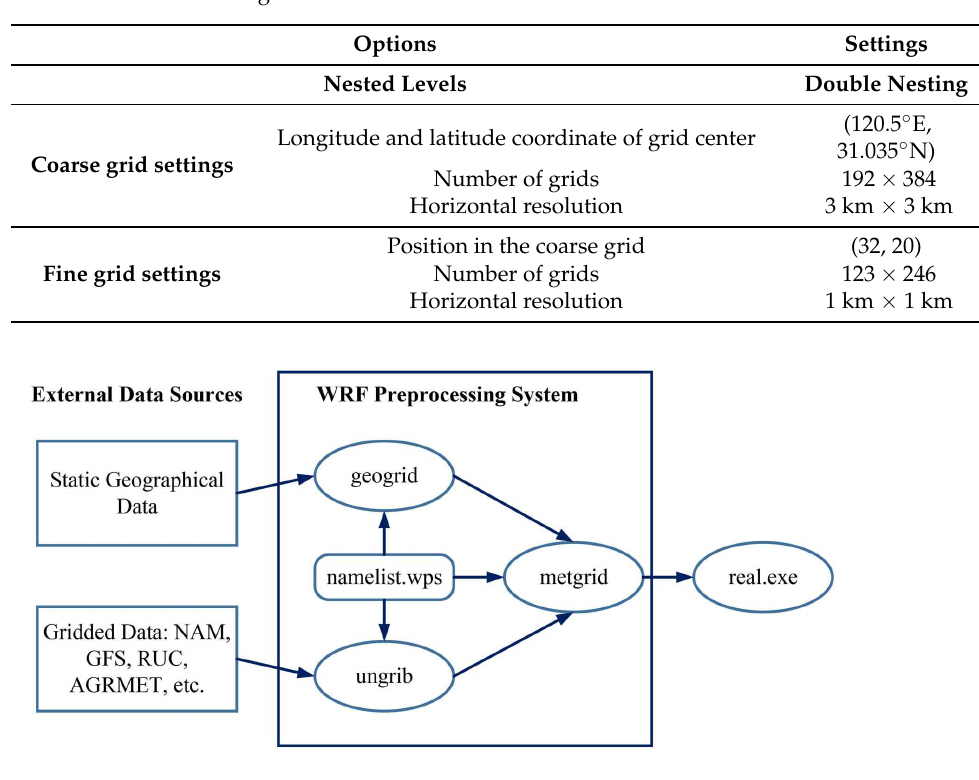
Table 1. Parameter settings of the WRF numerical simulation.